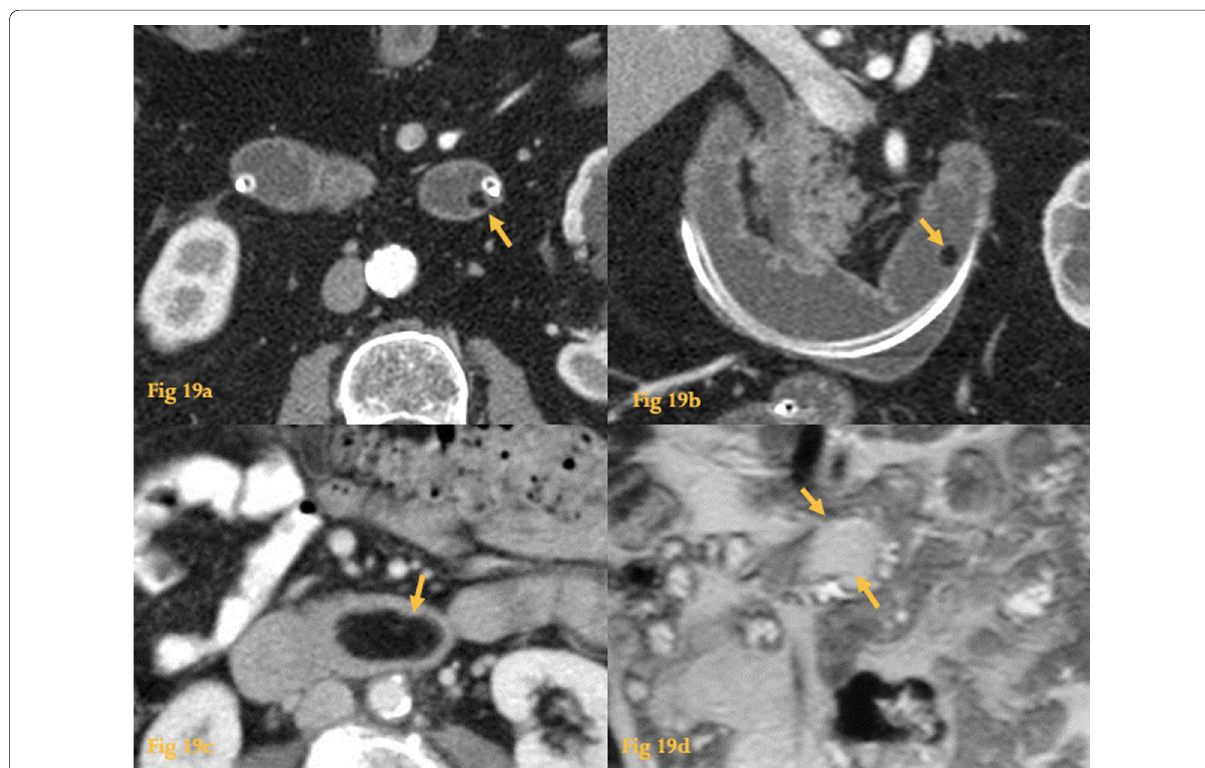
Fig. 19 Lipoma. CT enteroclysis, axial ( a ) and coronal reformation ( b ) a small endoluminal nodule, with fat density is seen protruding of the wall at D4 (arrows). Abdominal CT of another patient ( c ) shows a duodenal mass with homogeneous fat attenuation in the horizontal duodenum (arrow). MR coronal HASTE image ( d ) shows the mass has high signal intensity (arrows), equal to the mesenteric